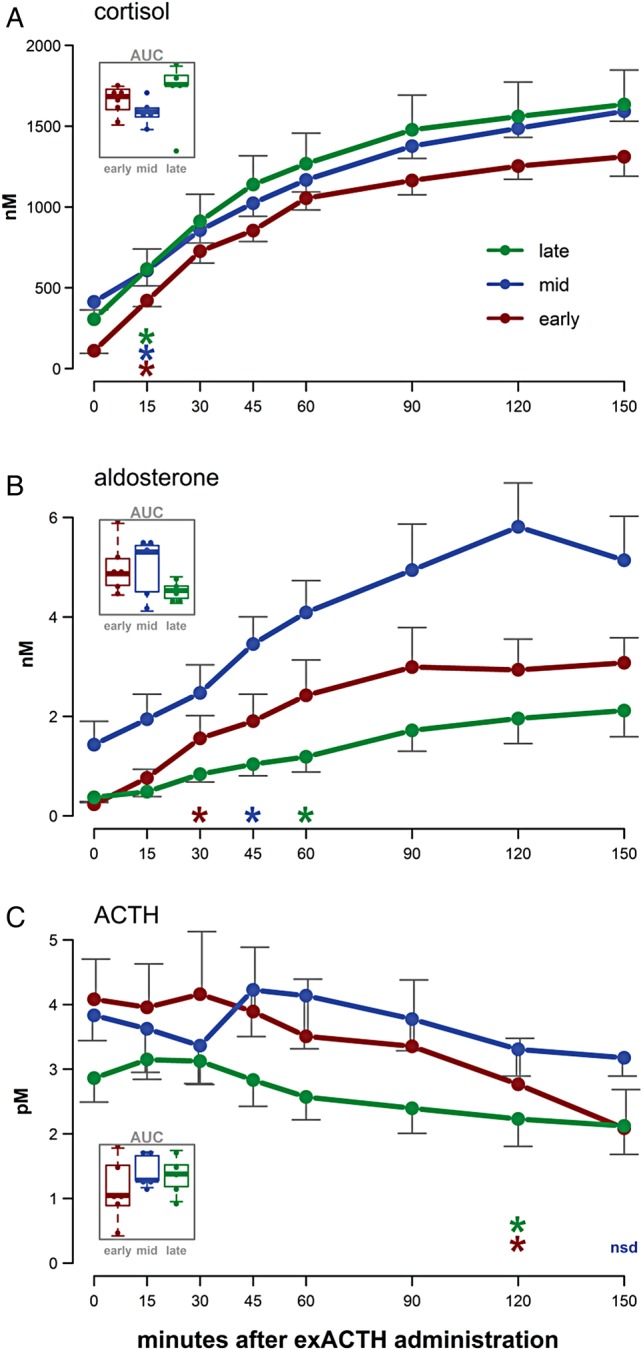
The responses of cortisol (A), aldosterone (B) and endogenous adrenocorticotrophic hormone (ACTH; C) to the administration of exogenous ACTH (exACTH) for each of the three study states: early, middle and late moulting. Initial values are shown at time zero. Coloured asterisks indicate that the hormone value at that time point and all subsequent time points differs significantly from the initial hormone value (Dunnett's test, P < 0.05); ‘nsd’ indicates no significant difference from time zero for any sample in that group. Error bars represent the SEM at each sampling time. An inset within each panel shows a comparison of the total hormone release over time, as area under the curve (AUC) values, among study groups; no differences in AUC values were detected, and the y-axis units are concentration × minutes (not shown).